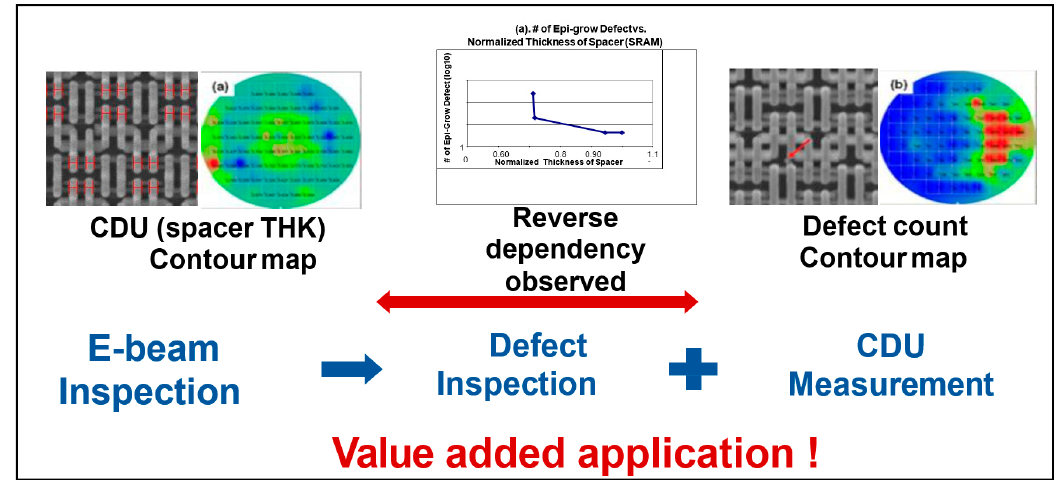
Figure 15. Combination of critical dimension unit Measurement and defect detection giving an overall value addition.